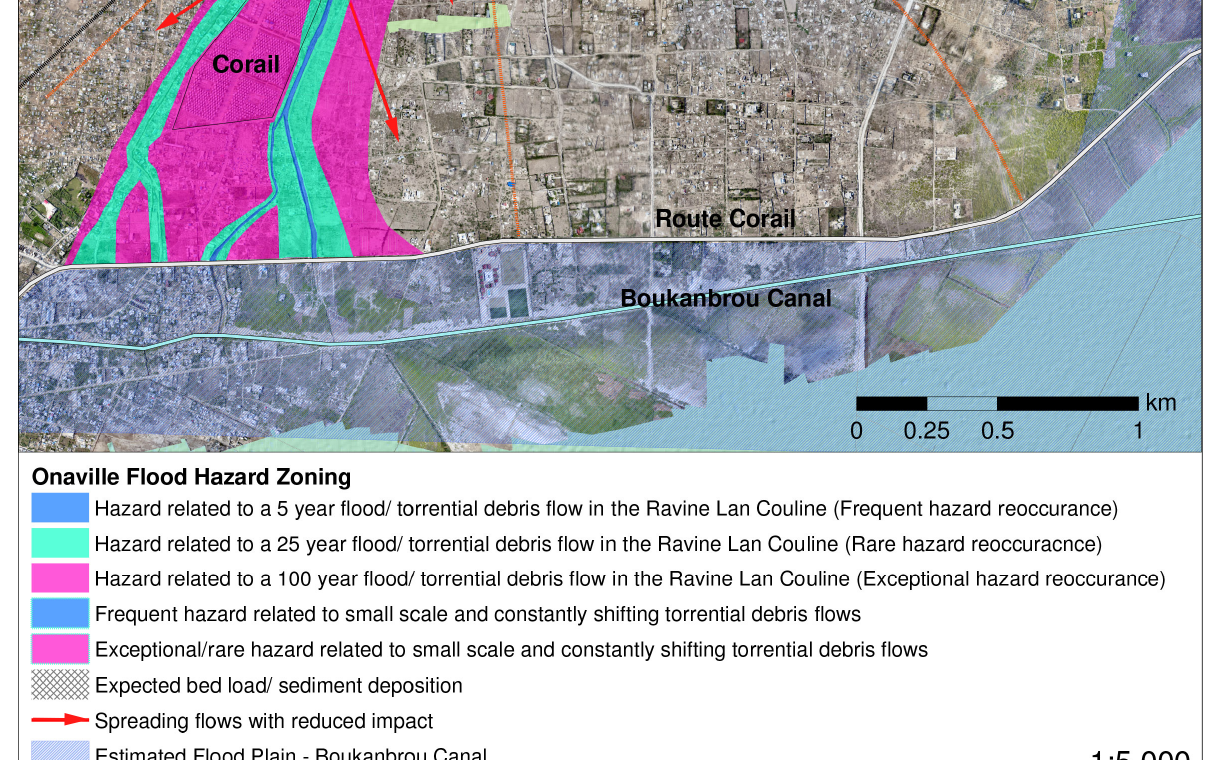
Figure 17. Flood hazard map of Onaville and the eastern part of Jerusalem